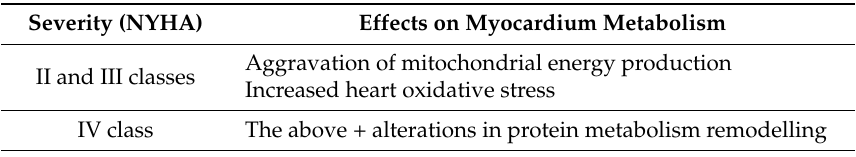
Table 6. Potential risks for myocardium metabolism from reduced arterial amino acids (AAs) in chronic heart failure (CHF).